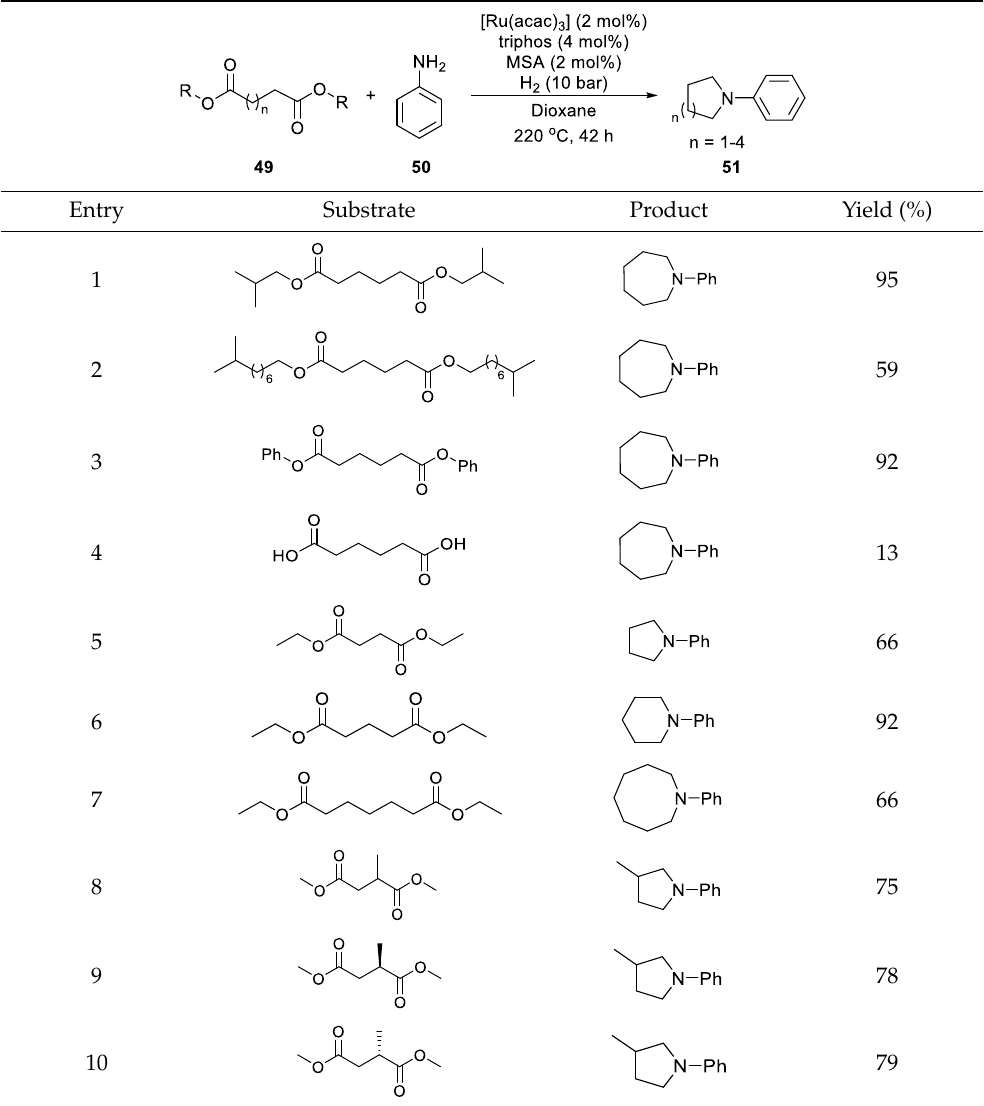
Table 1. Synthesis of azacycles from dicarbonyl substrates and aniline via hydrogenation.